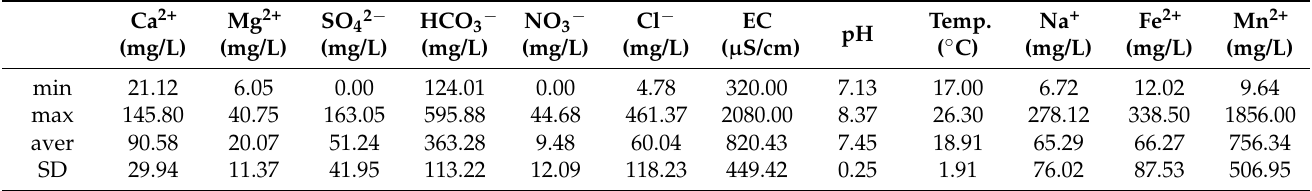
Table 3. Statistical analysis of some of the major chemical constituents from groundwater samples (October 2019) (unconfined